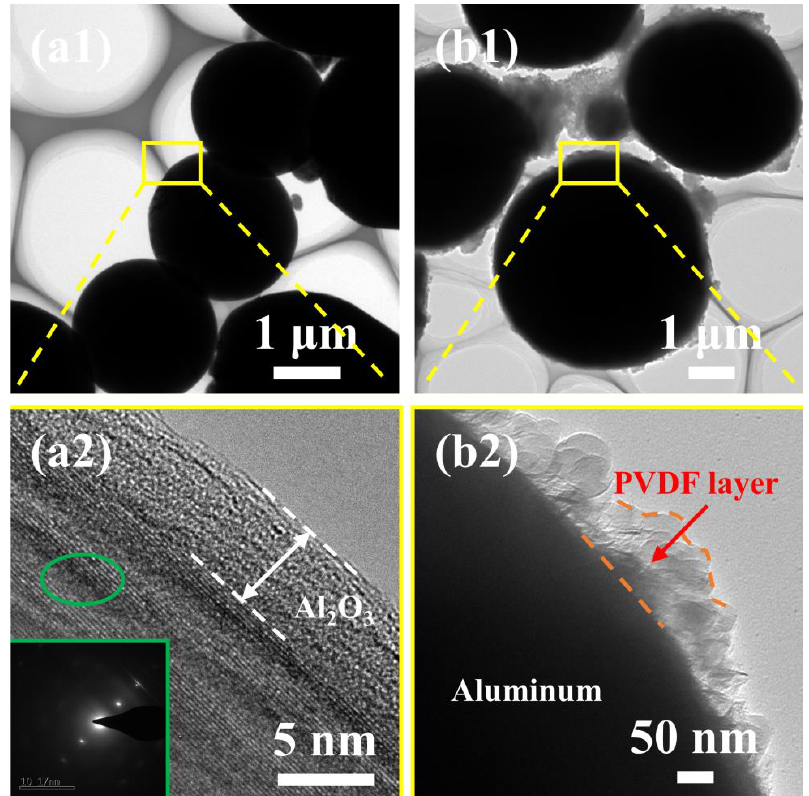
Figure 2. TEM images of Al powders ( a1 ) and Al@PVDF powders ( b1 ), enlarged TEM image of the Al 2 O 3 region ( a2 ), enlarged TEM image of PVDF-coated region ( b2 ). Al 2 O 3 region ( a2 ), enlarged TEM image of PVDF-coated region ( b2 ).